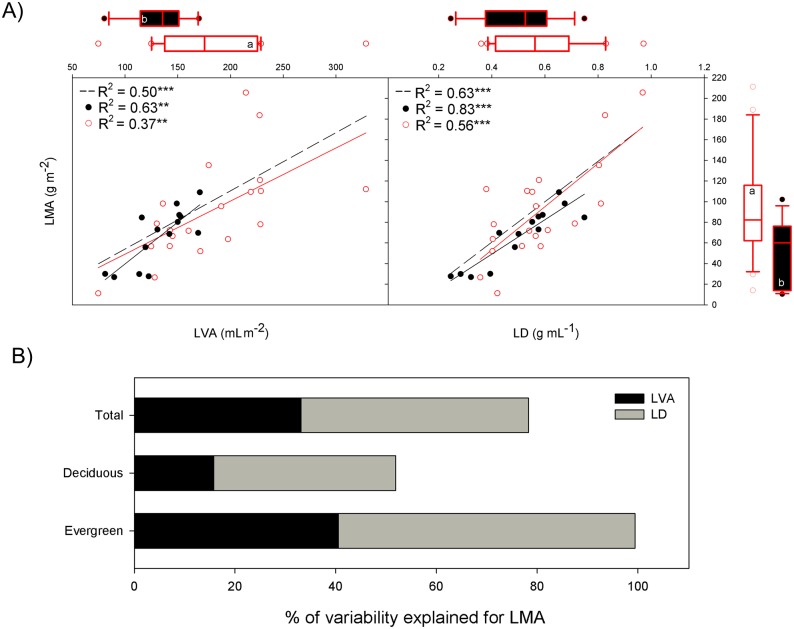
A) Linear regressions of leaf mass per area (LMA) with leaf volume per area (LVA or thickness) and leaf density (LD), for deciduous species (dark line and circles), evergreens (red line and empty red circles) and all the species (dashed line). The level of significance is expressed as follows: * P < 0.05, ** P < 0.01, *** P < 0.001. Box plots (median and 1st and 3rd quartiles) of deciduous vs. evergreen species are included in the margins; the significant results are based on the phylogenetic generalised least squares model (PGLS). The results based on PGLS can be found in S3 Table, Supporting Information. Whiskers show the minimum and maximum values that fall within 1.5x the length of the box away from the interquartile range; data further away are shown as outliers. B) Decomposition of the total variability explained by LVA and LD.